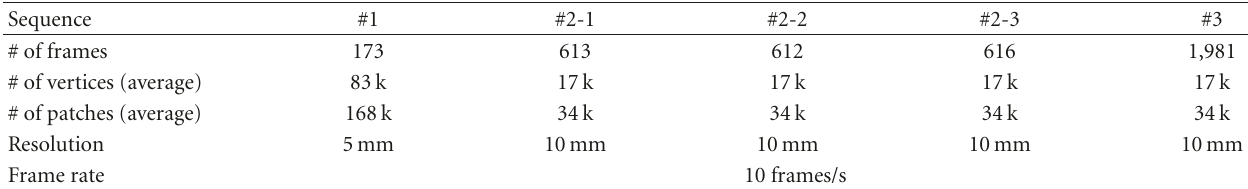
Table 1: Summary of TVM utilized in experiments. Sequence #1 and sequences #2-1–#2-3 are Japanese traditional dances called bon-odori